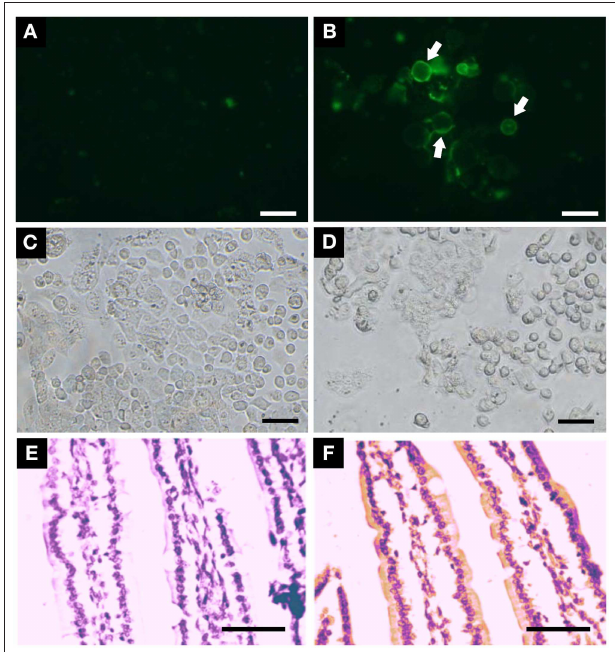
FIGURE 2 | PmPV2 binds to intestinal cells. (A,B) PmPV2 binding to intestinal cells in culture. Caco-2 cells were incubated for 1h with Alexa-488 labeled BSA as control (A) or with PmPV2 (B) . PmPV2 attached to cell surface is highlighted with arrowheads. Bar 25 µ m. (C,D) Same sections of BSA (C) and PmPV2 (D) treatments shown in A and B under bright field. Bar 25 µ m. (E,F) Immunolocalization of PmPV2 at brush border intestinal mucosae of mice fed on a diet without (E) and with (F) 400 µ g PmPV2 (PmPV2 location appears as yellowish regions). Bar 50 µ